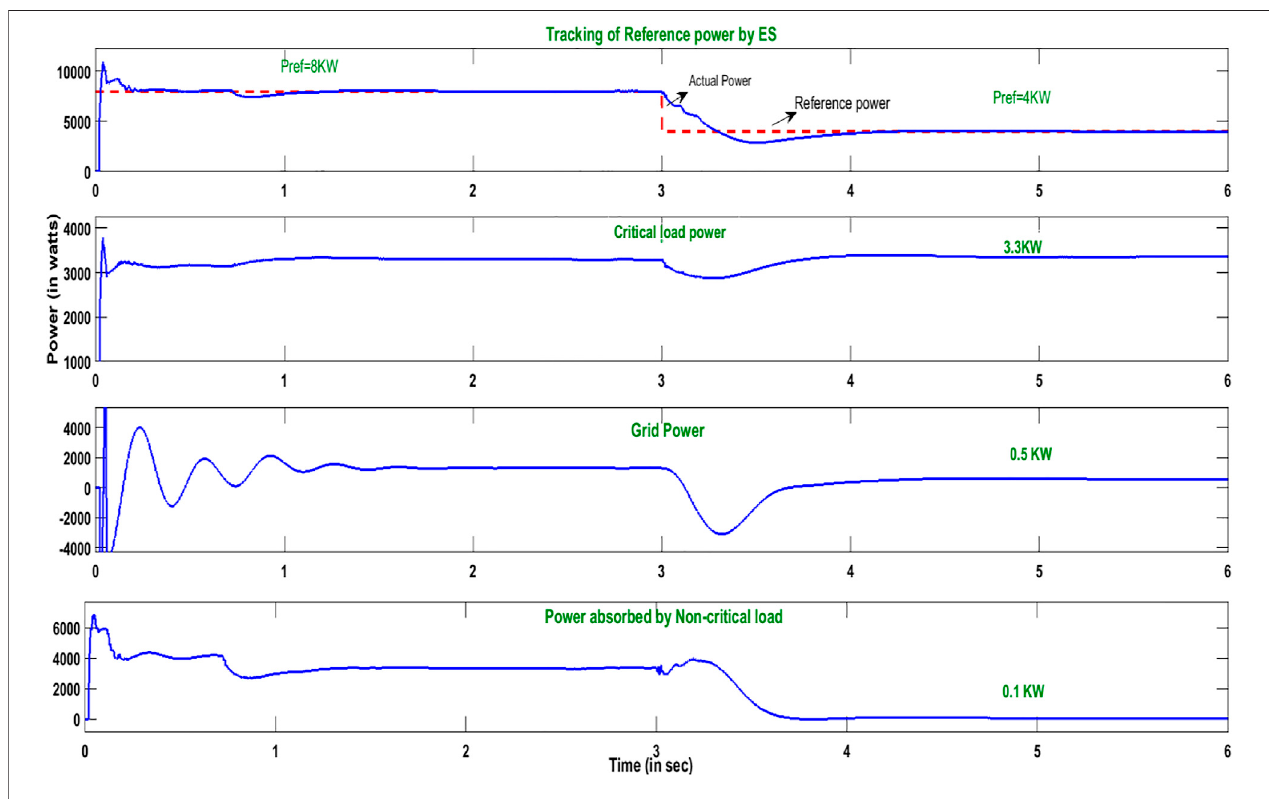
FIGURE 6 | Power variations for step change in reference power.